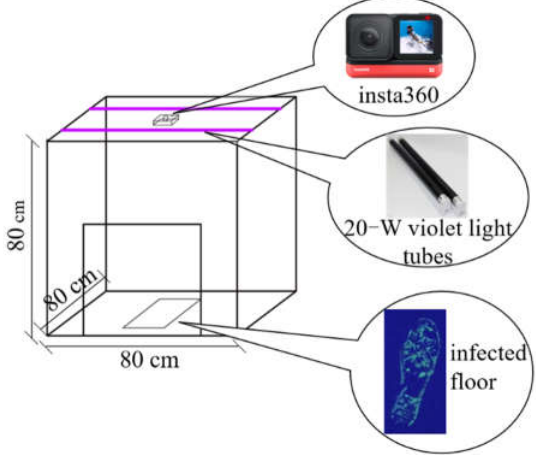
Figure 2. Schematic of the fluorescence image acquisition device.